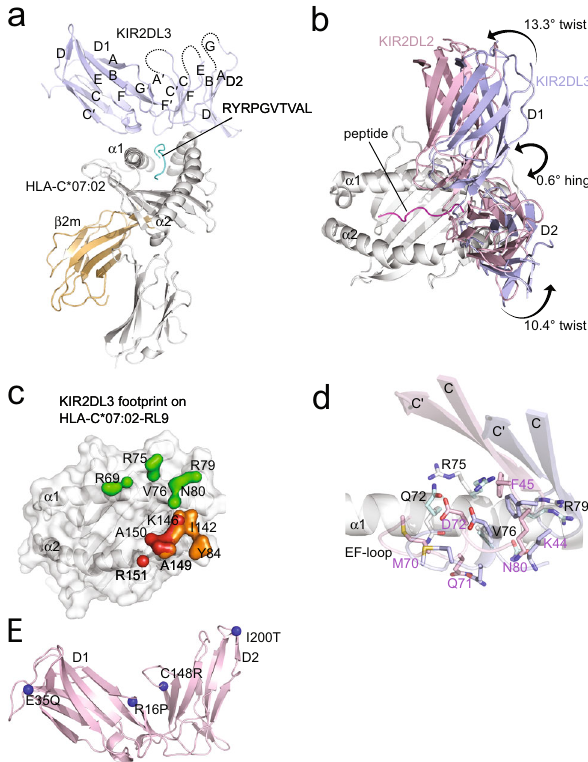
Fig. 2 Structural comparisons of KIR2DL2 and 2DL3 in complex with HLA-C*07:02-RL9. a Overall structure of KIR2DL3 in complex with HLA- C*07:02-RL9. The complex is represented in cartoon format with KIR2DL2 coloured blue, HLA-C*07:02 coloured grey, β 2 m coloured orange and the peptide coloured cyan. b Comparison of KIR2DL2 (pink) and 2DL3 (blue) in complex with HLA-C*07:02-RL9. The relative difference in hinge and twist angles of the KIR is shown. c Footprint of KIR2DL3 on HLA-C*07:02-RL9 coloured by domain binding. D1 contacts coloured green, D1-D2 interdomain loop contacts coloured red and D2 contacts coloured orange. d Comparison of KIR2DL2 (pink) and KIR2DL3 (blue) D1 contacts to the α 1- helix of HLA-C*07:02-RL9 (KIR2DL2 contacts coloured grey, KIR2DL3 contacts coloured cyan). The ~3 Å shifts of the D1 C-C ′ and E-F loops are highlighted. e Mapping of sequence differences to the structures of KIR2DL2/3. Differences highlighted as blue